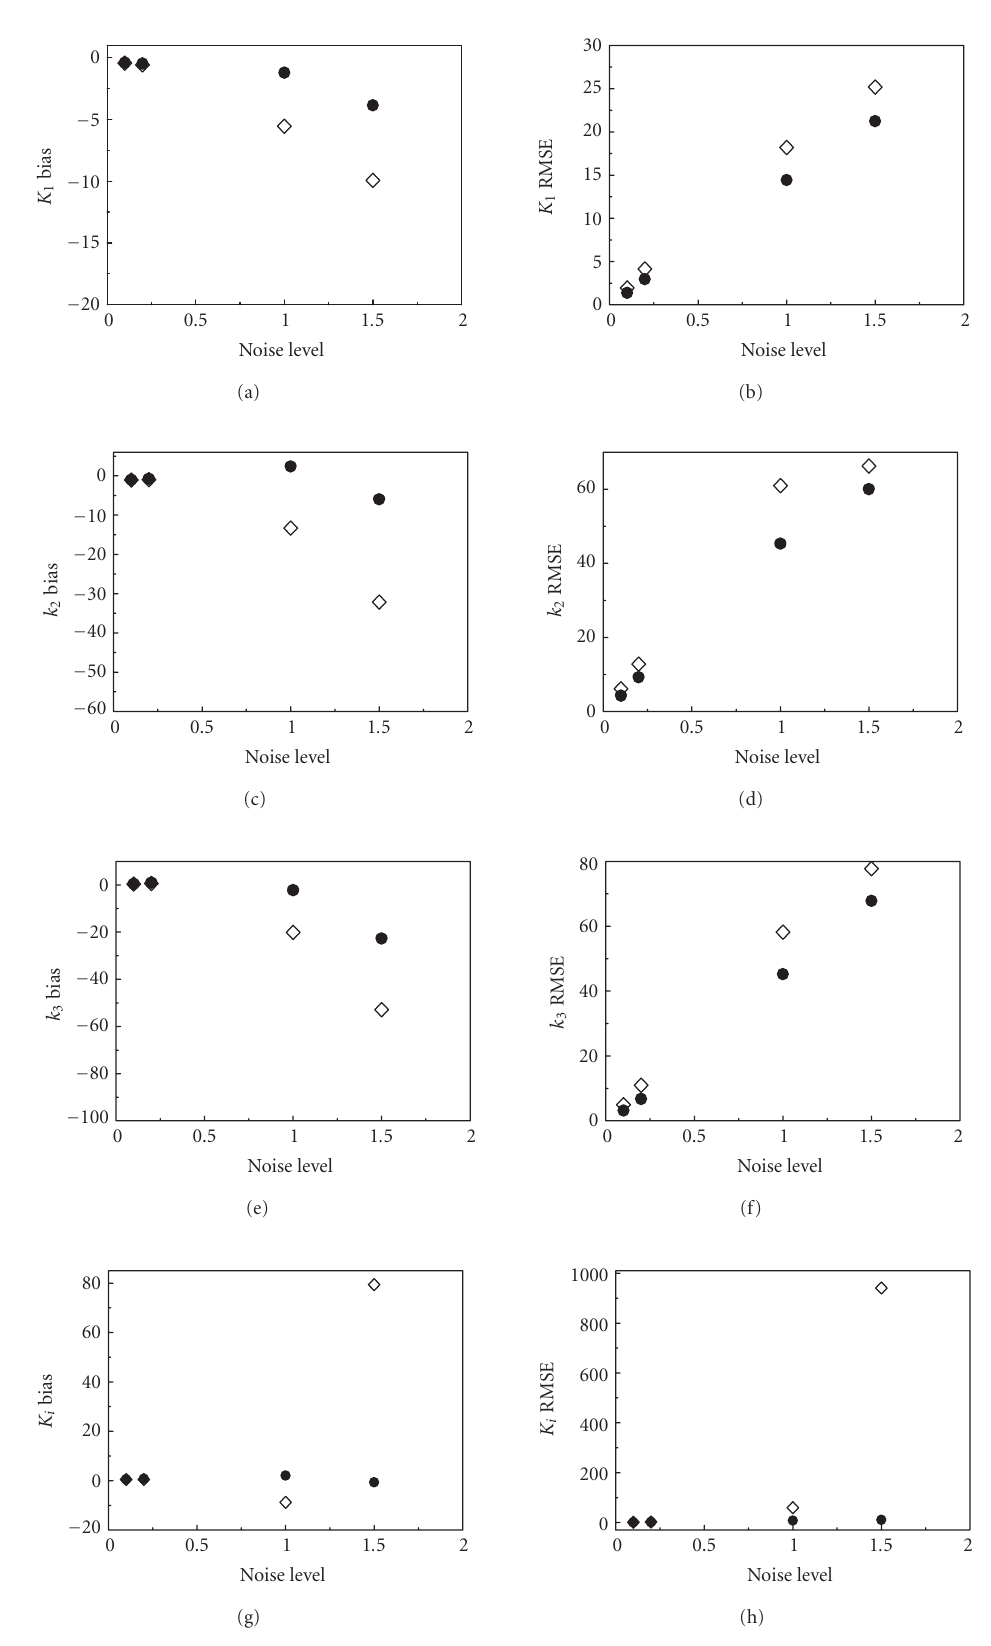
Figure 2: Bias and RMSE of estimated parameters for the simulation data at di ff erent noise levels (diamond for LLS results; filled circle for cLLS